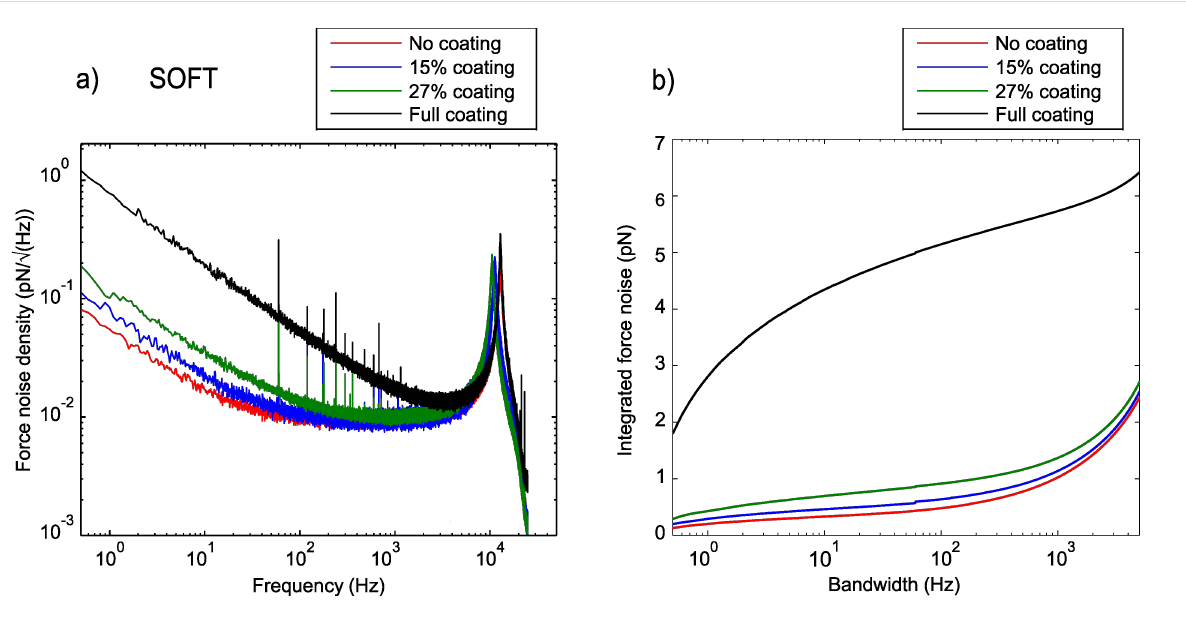
Figure 3: (a) Force noise density spectra for the soft cantilevers obtained from Figure 2 by multiplying with the measured spring constants. (b) The force noise density is integrated to show the expected force noise at a certain bandwidth (0.3 Hz–5 kHz). This sets the minimum force noise with these cantilever, independent of the measured signal. The partially coated cantilever and uncoated cantilever show a sub-pN force noise over a wide range of possible bandwidth (0.5 Hz–1 kHz), whereas the fully coated cantilever shows a strong increase.